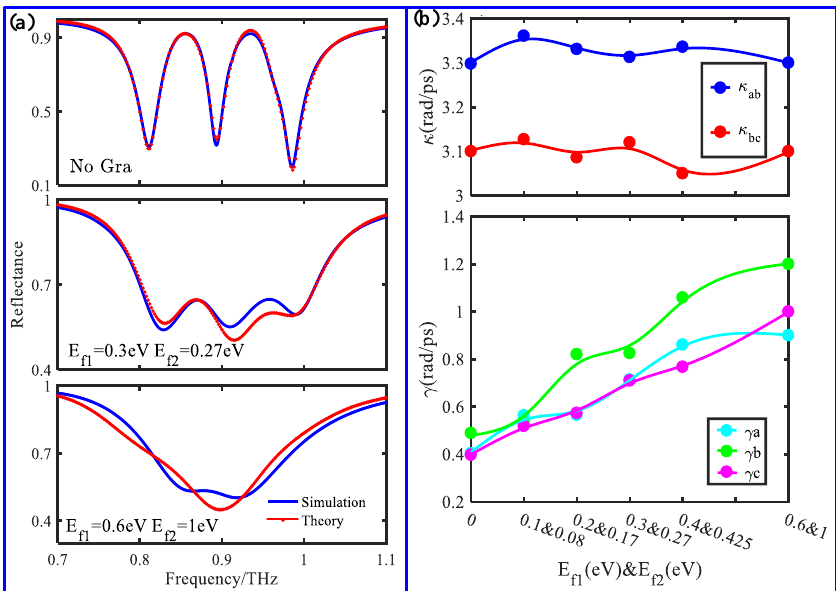
Figure 6. ( a ) Comparison of simulated and theoretical results for different Fermi energies and ( b ) fitting parameters κ ab , κ bc , γ a , γ b , and γ c as the function of the Fermi energy.